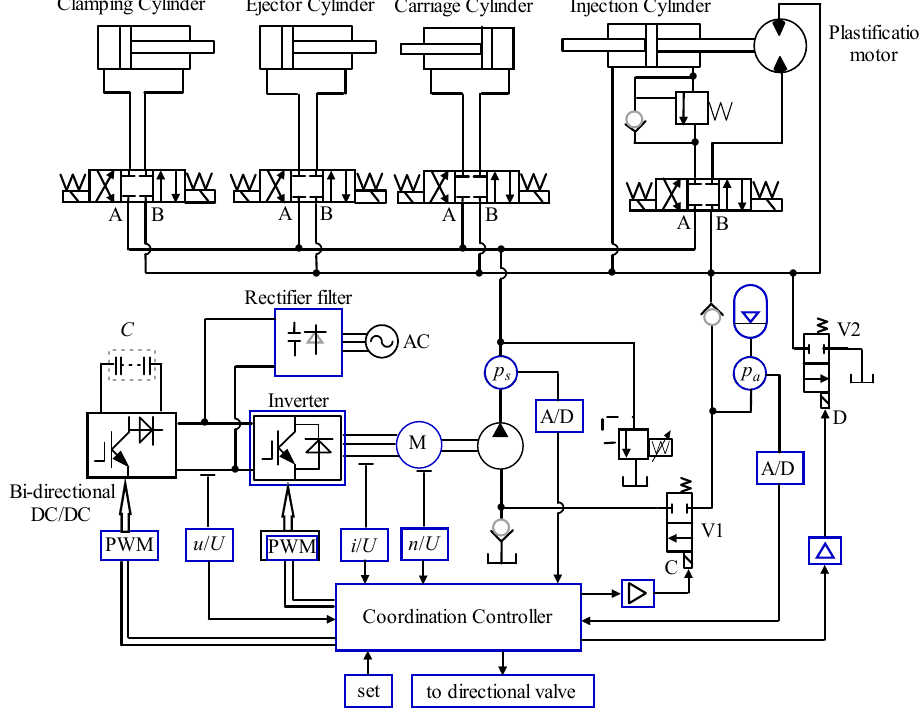
Figure 11. The principle of the coordination control strategy.